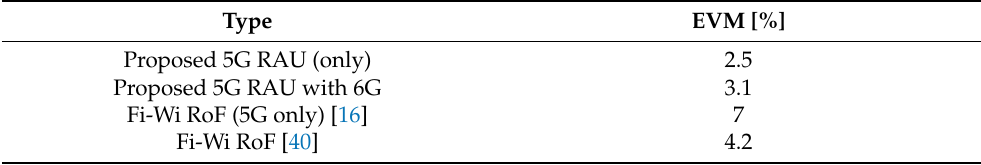
Table 2. Summary and comparison with the relevant state of the art at RF input power of 0